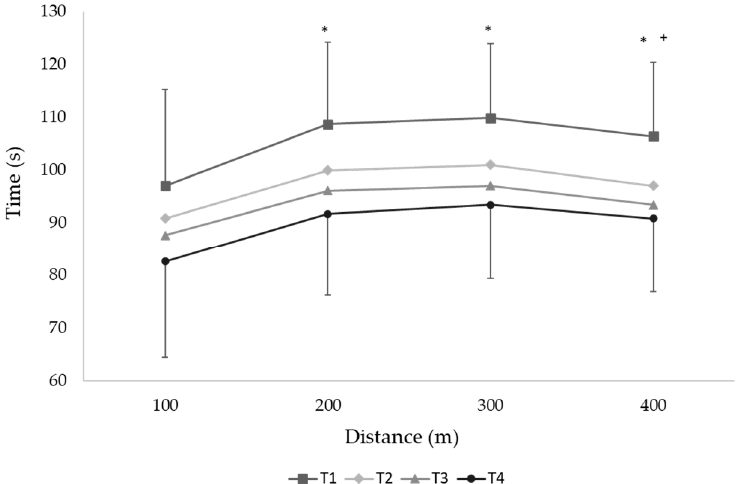
Figure 1. Time for each 100 m split in the 400 m front crawl effort at testing moments T1 (beginning of the first macrocycle) and T2, T3, and T4 (end of the first, second, and third macrocycles, respectively). * and +: p < 0.05 compared to 100 m partial and to 200 and 300 m partials. Table 3. Changes in swimmers’ anthropometric, physiological, and biomechanical variables dur- ing the four 400 m front crawl testing moments. Mean ± SD, 95% confidence intervals (95% CI), and effect size (ES) are presented.